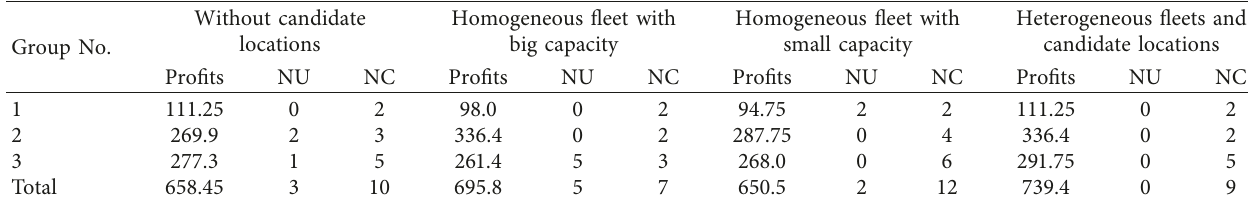
Table 19: Results comparison in different